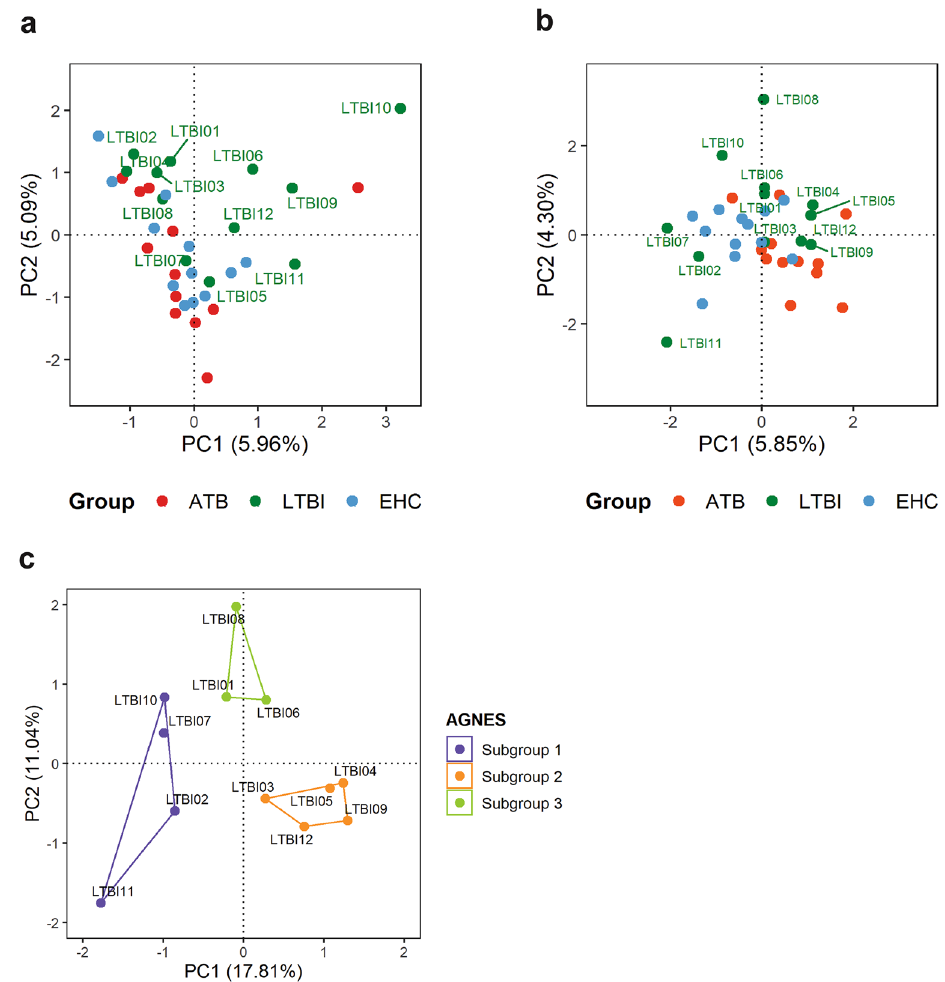
Figure 1. Principal component analysis of peptide-specific antibody responses and identification of LTBI subgroups. Individual factor maps (PCA) of IgG ( a ) and IgA responses ( b ), characterised by 11,766 and 7809 peptides, respectively, demonstrated distribution of individual samples (n = 36). Greater distances between ATB, LTBI, and EHC groups and within LTBI samples were notable in IgA dataset. LTBI subgroups were suggested by differing responses to the drPeptides and later identified by PCA and AGNES using IgA signals against all 16,730 peptides in the library ( c